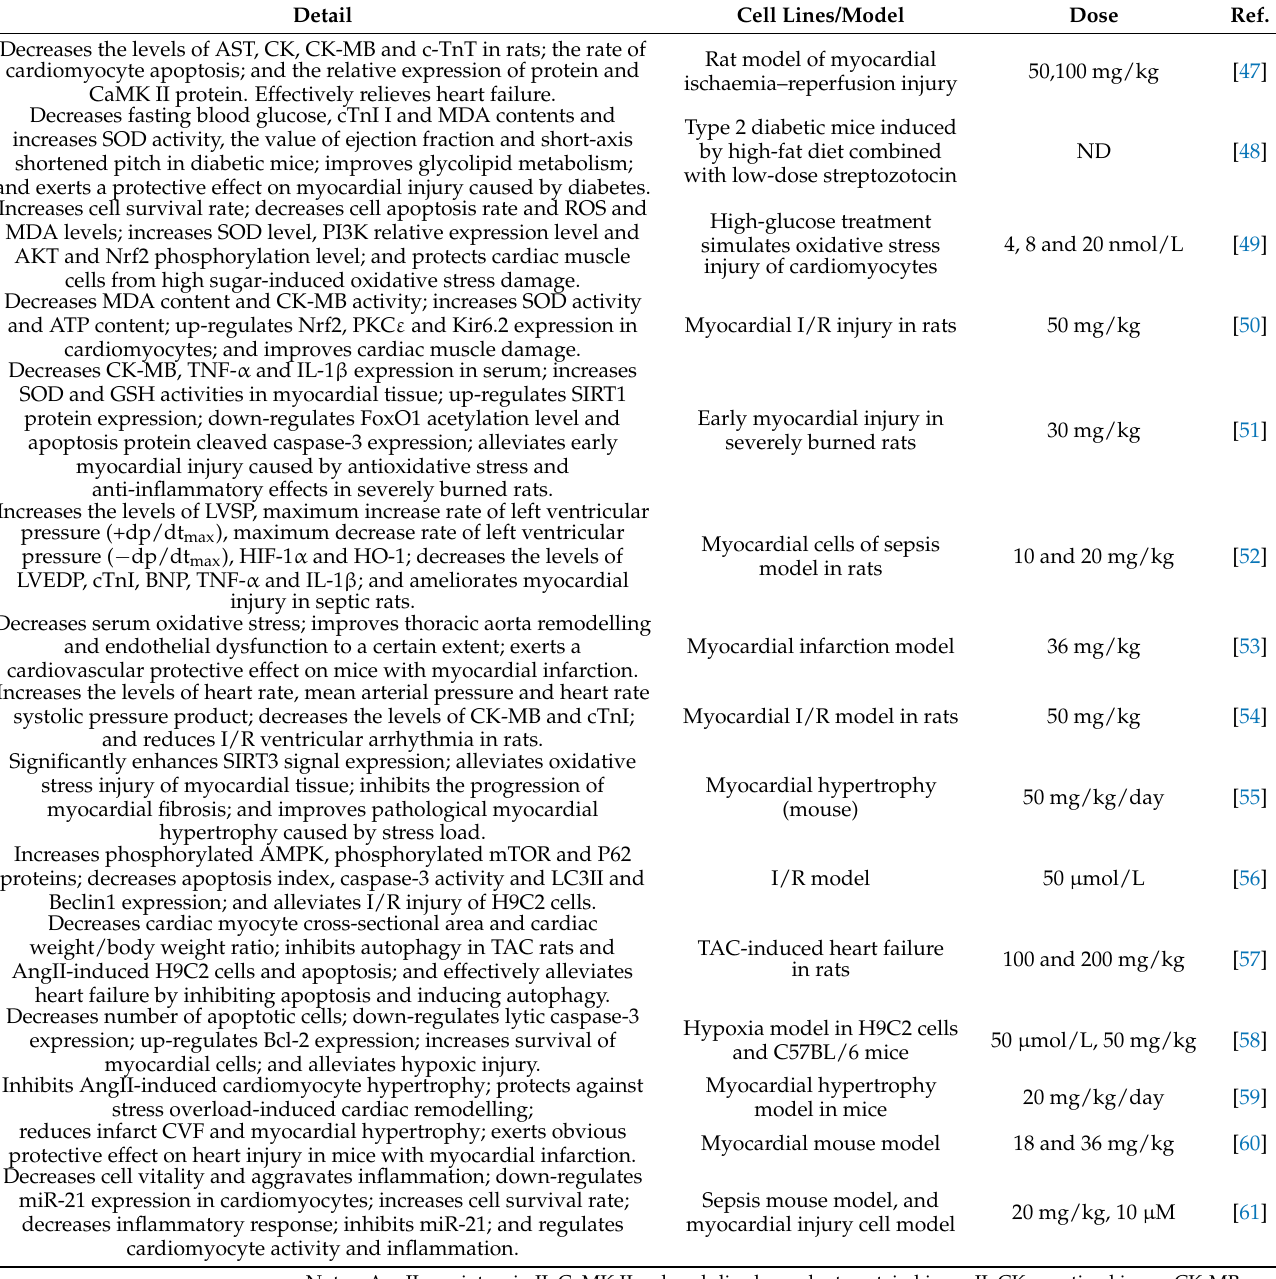
Table 3. Cardioprotective Activity of